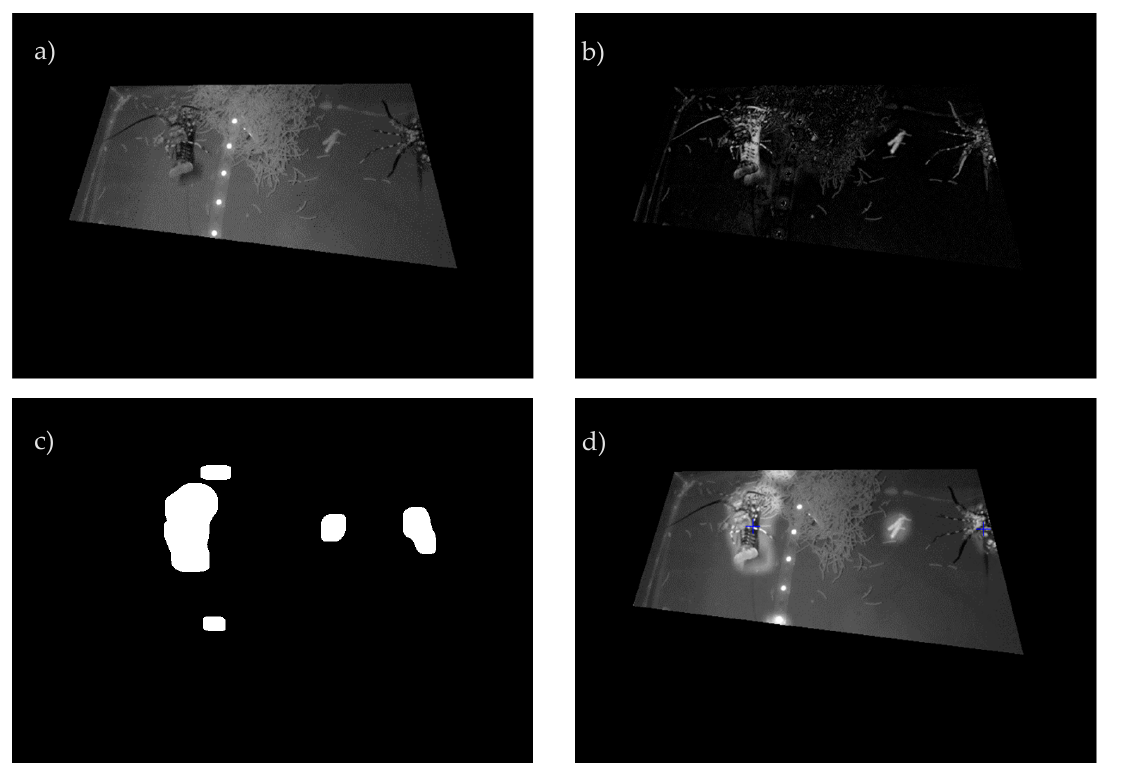
Figure 2. Detection of juvenile lobsters within an aquaculture test tank using adaptive background subtraction. ( a ) Original image with masked region of interest (ROI), ( b ) following background subtraction, ( c ) output of morphological operations identifying candidate detections and ( d ) identification of likely positive detections (blue markers) following statistical vetting of candidates overlayed onto the masked original image with all potential detections highlighted.